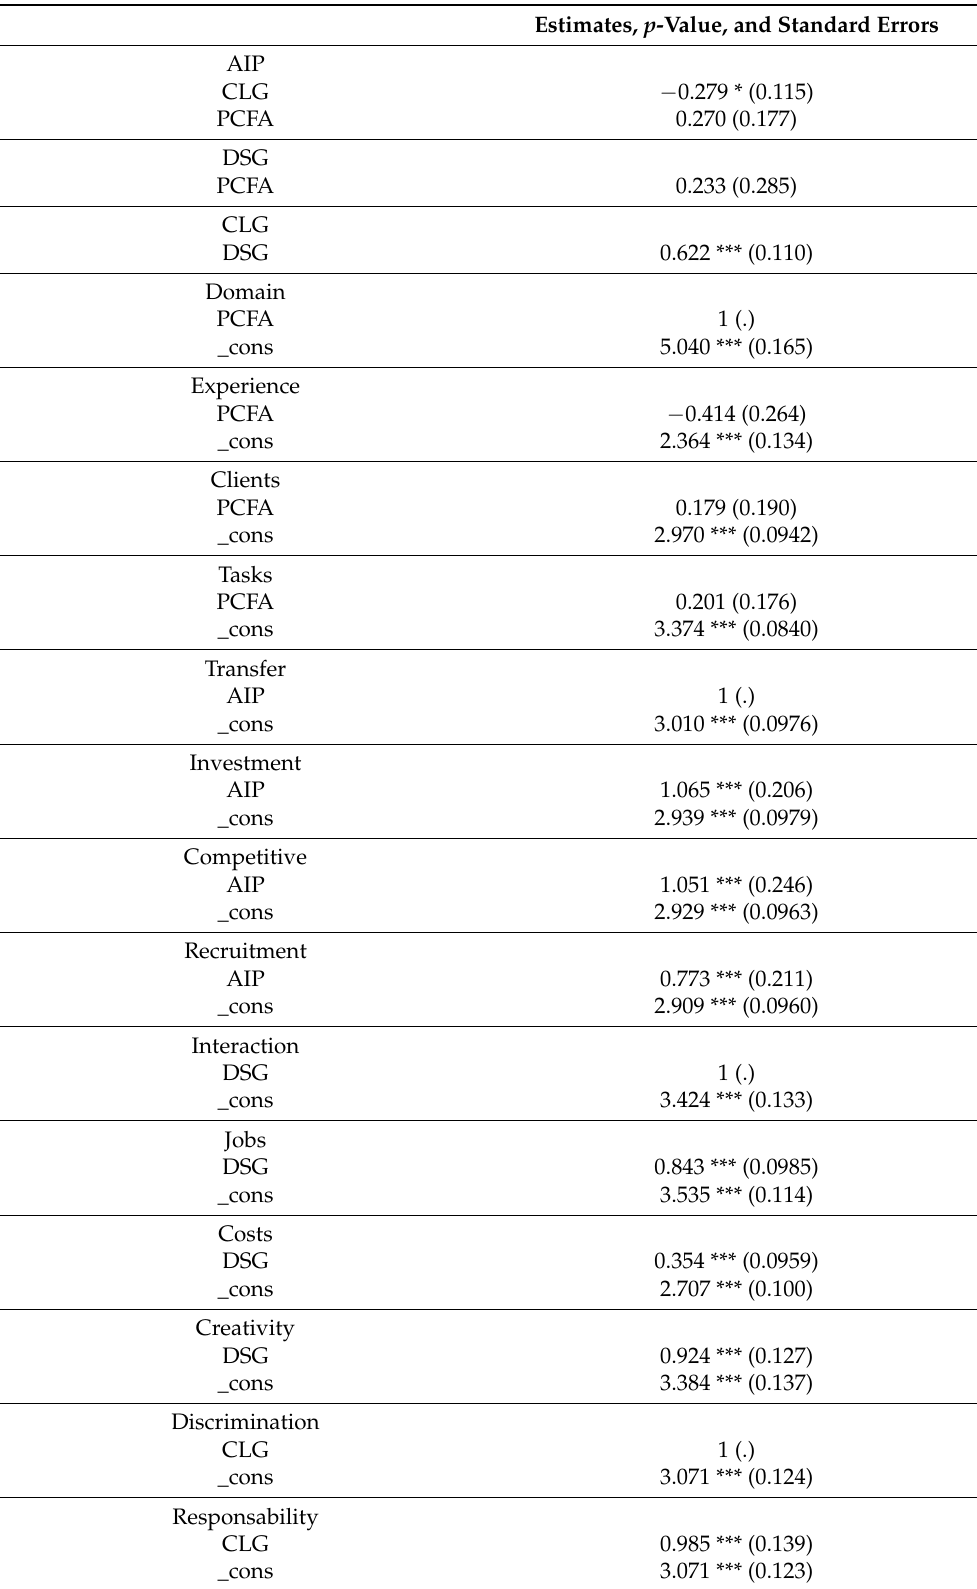
Table A4. SEM detailed